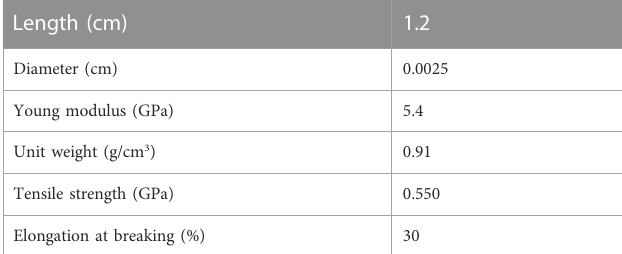
TABLE 5 Polypropylene fi bre ’ s physical characteristics.